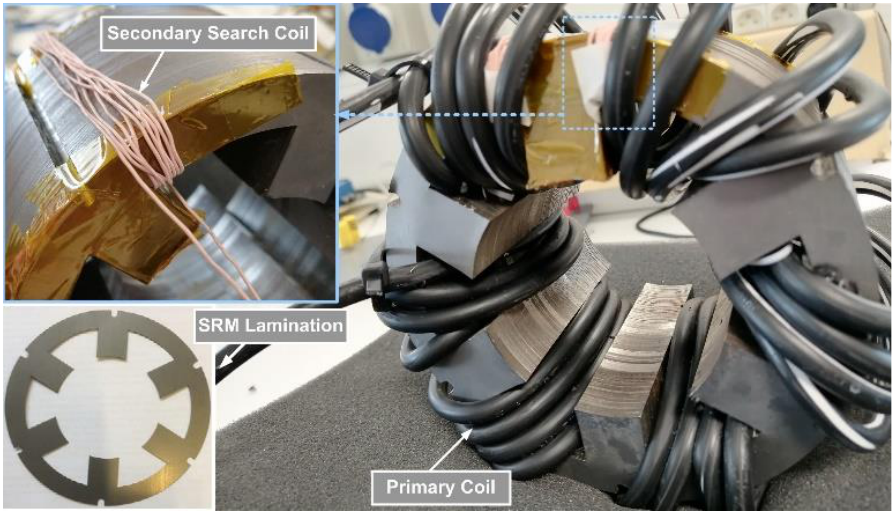
Figure 6. Preparation of the double coil system in the full axial length stator for magnetic material characterization.